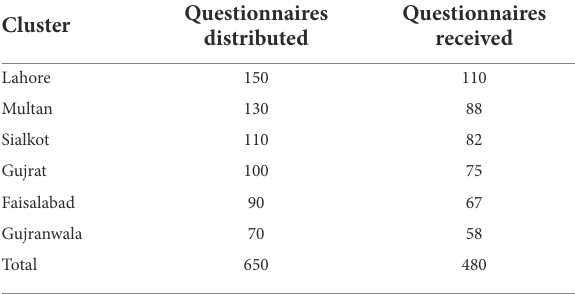
TABLE 2 Questionnaires distributed and collected.